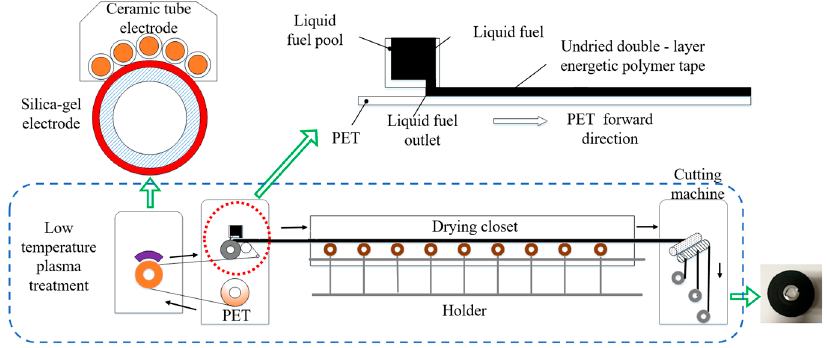
Figure 2. Double-layer tape production system and flow chart.